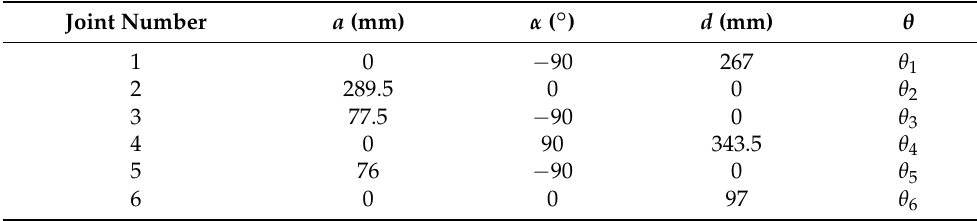
Fig. 1 Frame assignment of Xarm6 Figure 1. Frame assignment of Xarm6. Table 2. D-H parameters of Table 2 D-H parameters of Xarm6